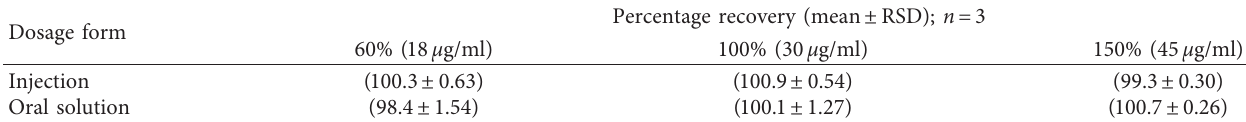
Table 3: Percentage recovery at three levels (60, 100, and